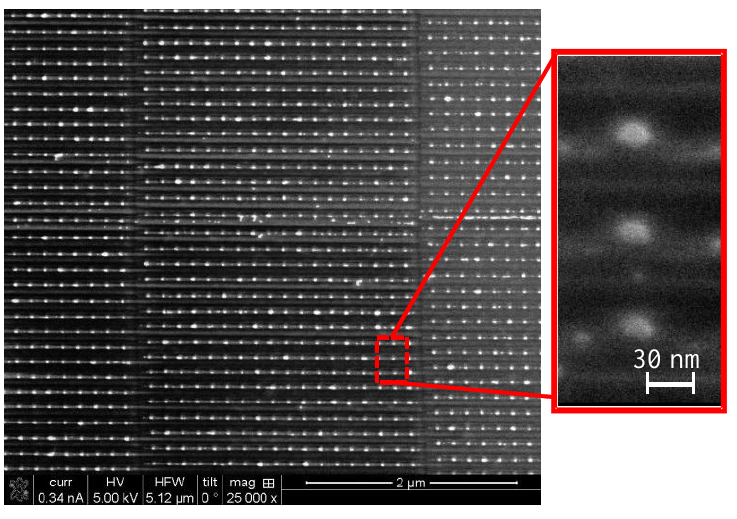
Figure 6. SEM image of the fabricated